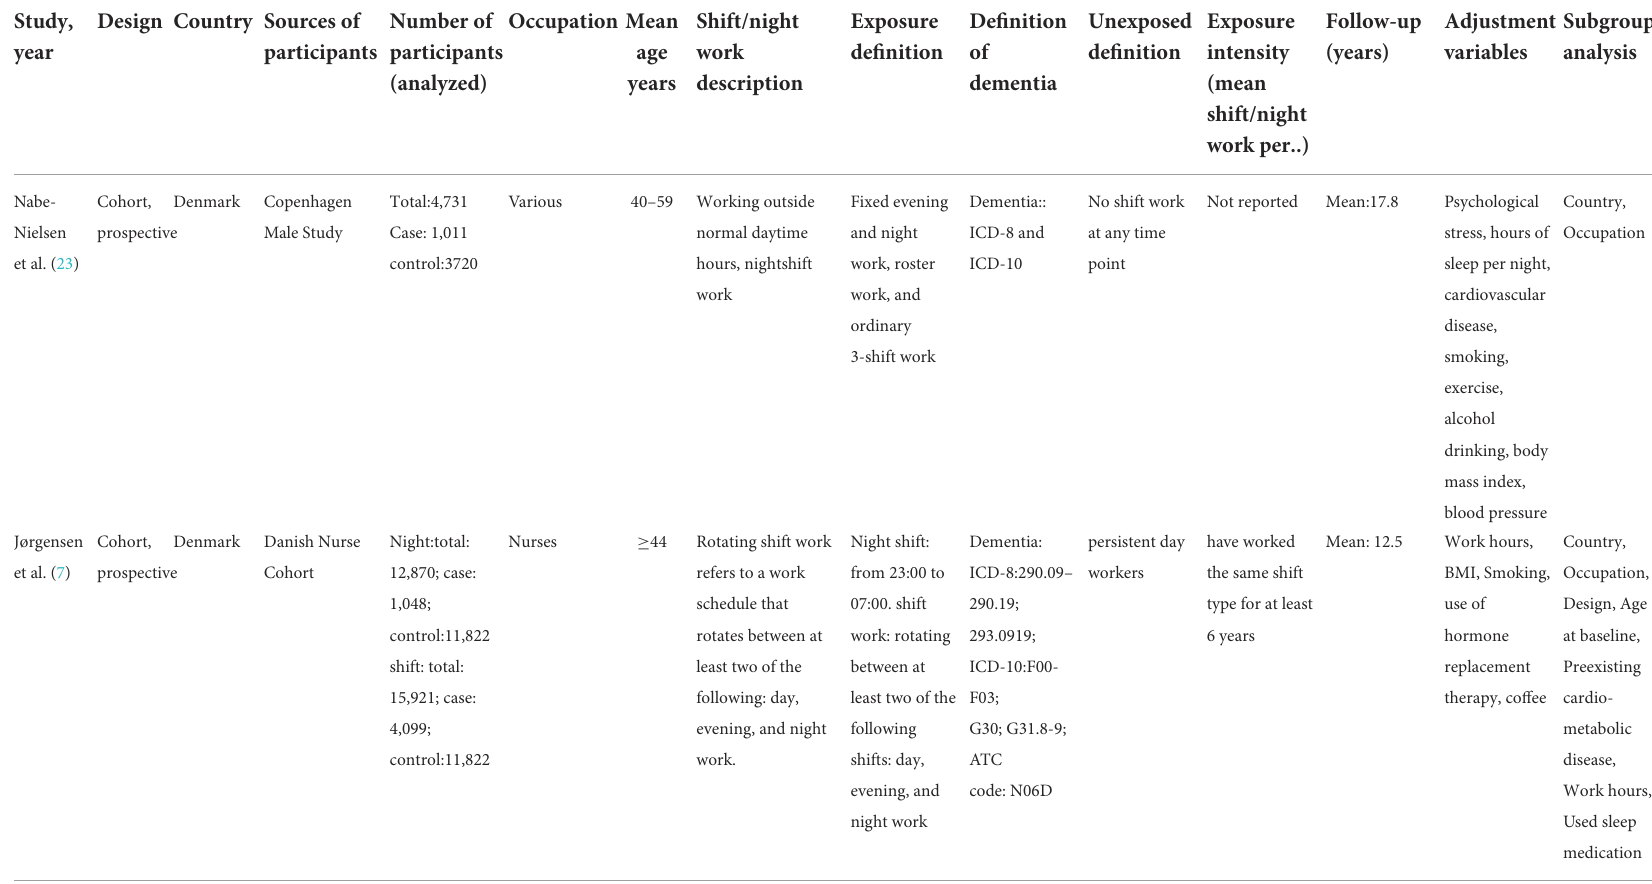
TABLE 1 Main characteristics of the included